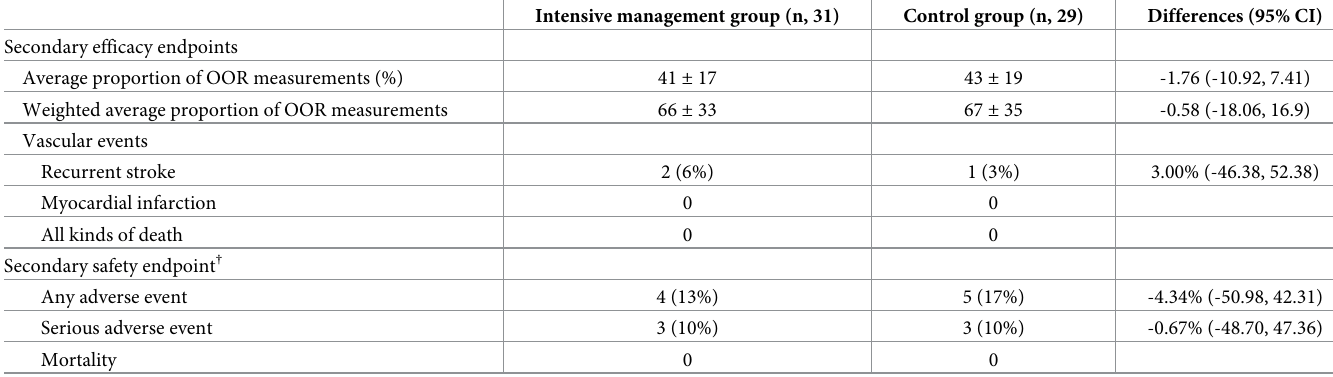
Table 3. Secondary outcomes of the